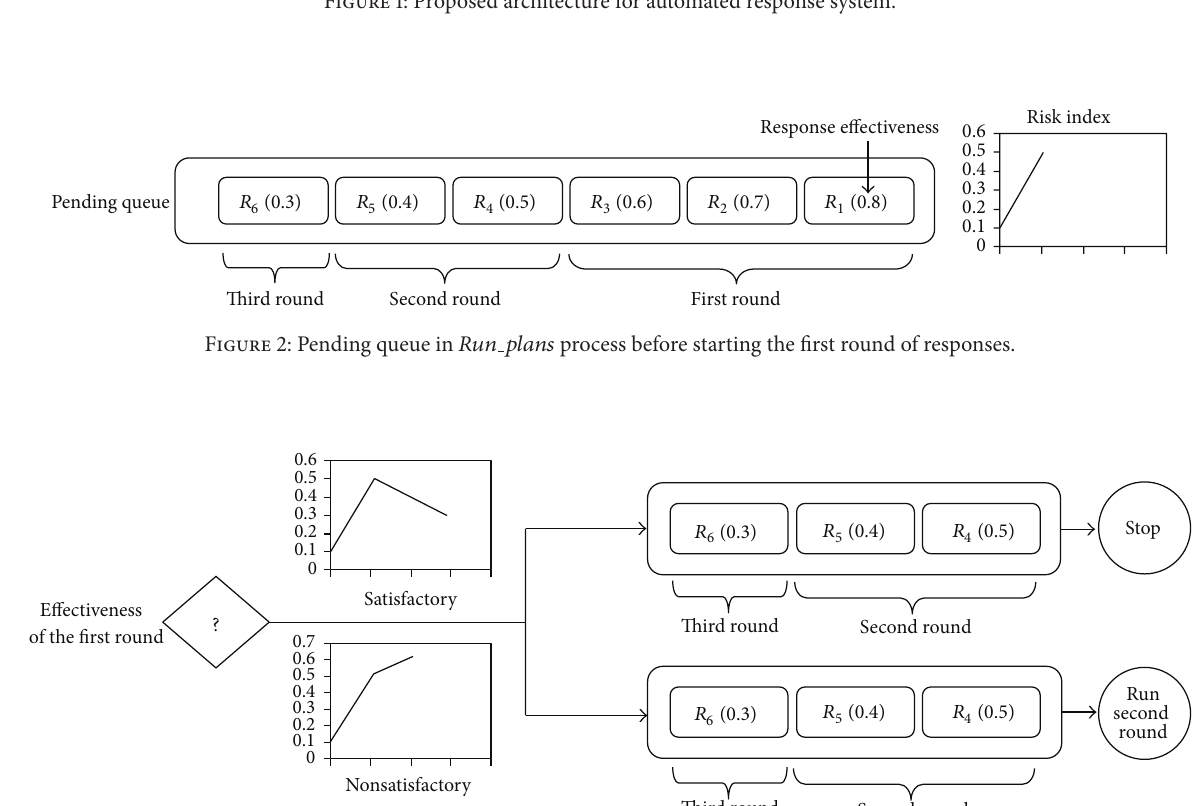
Figure 1: Proposed architecture for automated response system.